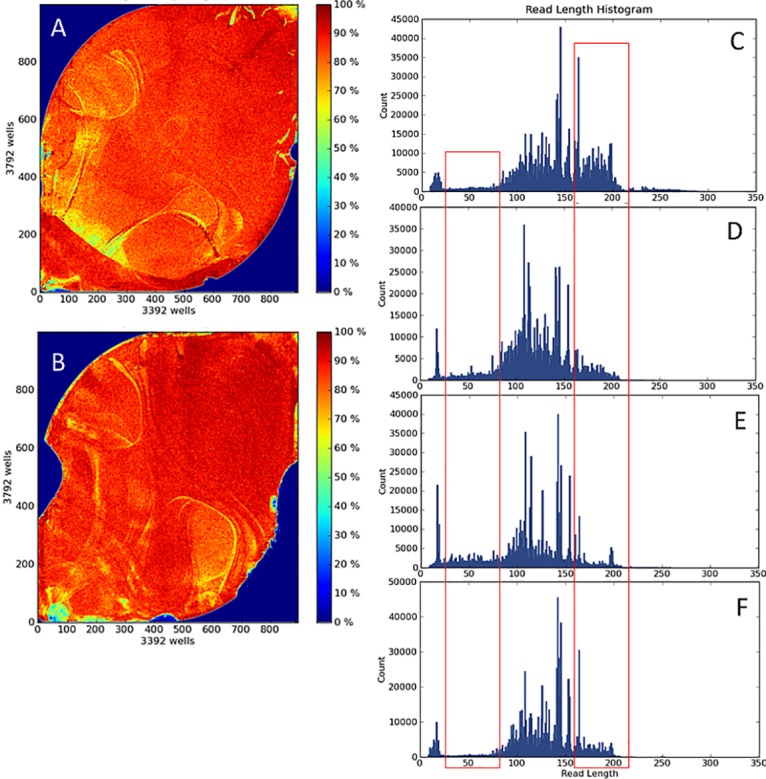
Technical run data from Torrent Server.(A) Loading intensity of 318 v2 chip with 6 aspirate samples. (B) Loading intensity of 318 v2 chip with 6 FFPE samples isolated with the standard protocol. Read length histogram represent selected samples from aspirate (C), standard protocol (D), GeneRead Kit (E), and standard protocol + UNG pre-treatment (F) sample sets.